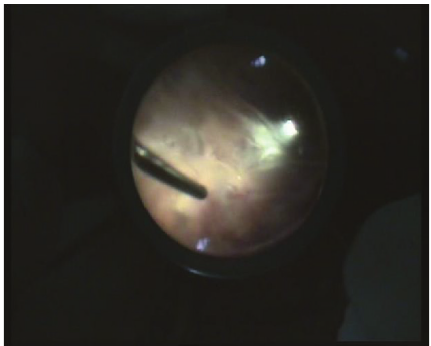
Figure 1: PPV in traumatic endophthalmitis.